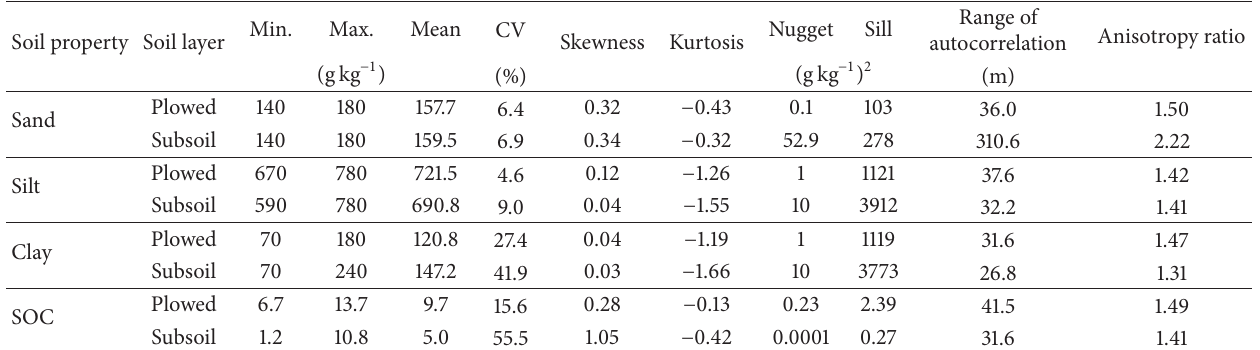
Table 4: Statistics of soil properties and parameters of isotropic spherical models of